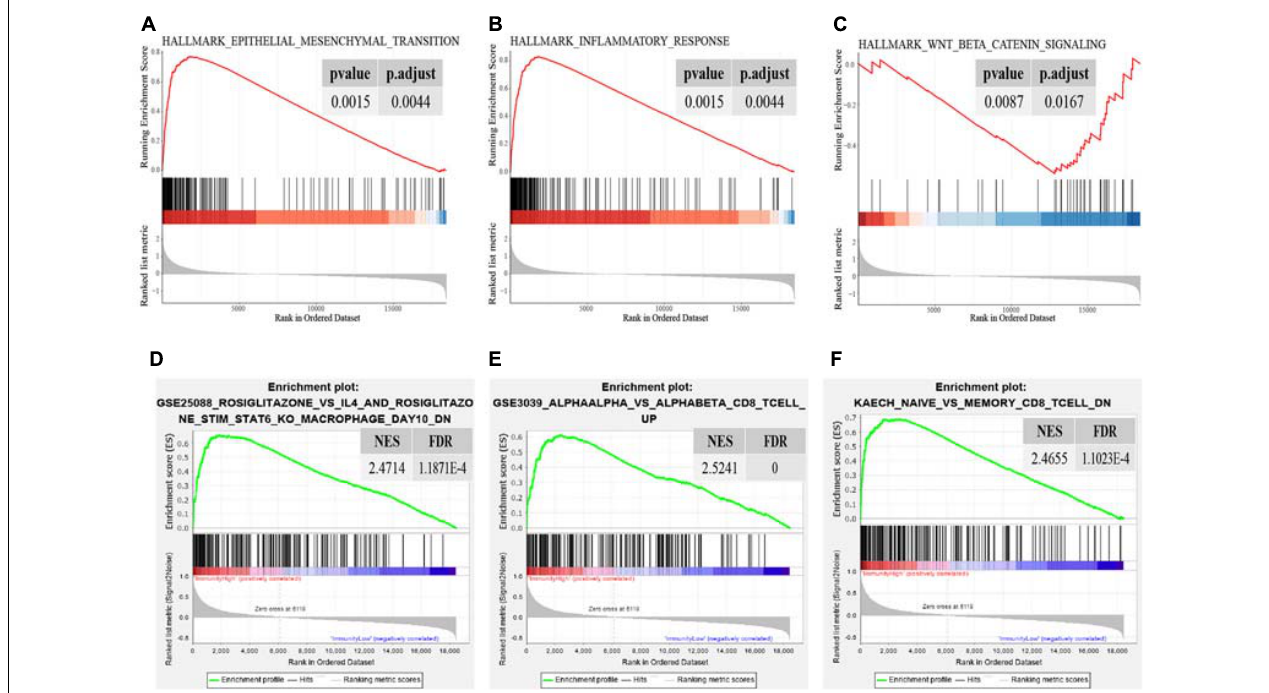
FIGURE 3 | Significant enrichment terms for GSEA in “hallmarker gene sets” (A–C) and in “c7 immunologic signature gene sets” (D–F) . The significance of NES was all adjusted on behalf of the false discovery rate. NES, normalized enrichment score; FDR, false discovery rate.